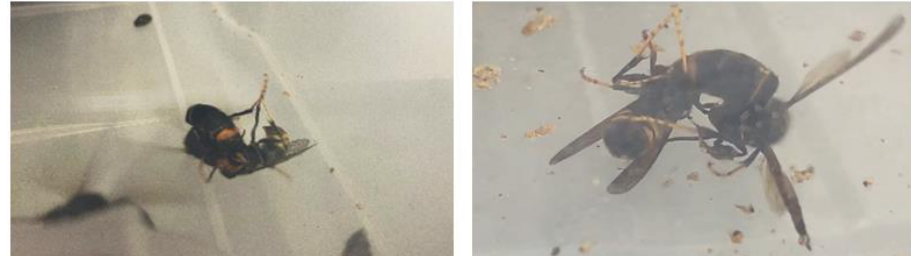
Figure 5. Vespa velutina female hornets fighting each other shortly after the nest was collected.